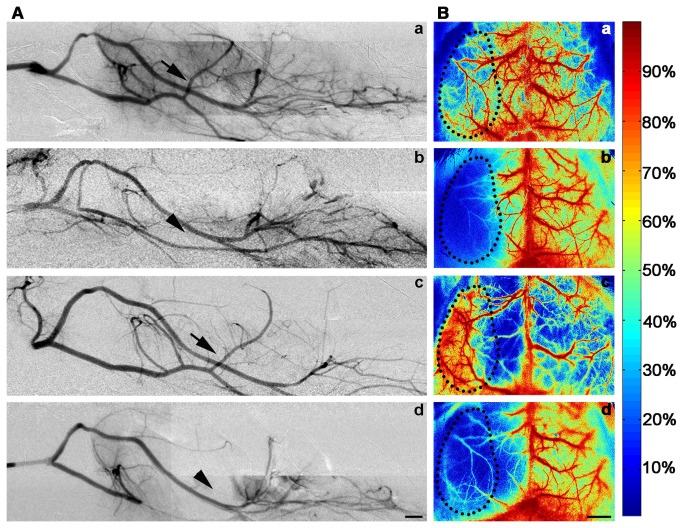
Mouse cerebral vascular morphology imaged by SRA and blood flow measured by LSCI.(A) Cerebral vascular morphology imaged by SRA. (a) cerebral vascular morphology was obtained before middle cerebral artery occlusion (MCAO) in adult mice. CCA, ICA, PPA, PCA, MCA and ACA as well as their branches could be clearly detected. (b) SRA after MCAO showed that CCA, ICA, PPA and PCA could be detected while MCA was missing, suggesting that MCA was occluded. (c) SRA was performed 1 hour after reperfusion in heparin-treated mice, which showed CCA, ICA, PPA, PCA and MCA were well filled with contrast agent Ipamiro. (d) SRA was performed 1 hour after reperfusion in the heparin-free mice, which showed CCA, ICA, PPA and PCA could be detected while MCA was still undetectable. (B) CBF was measured by LSCI. (a) LSCI was recorded in normal mice showing that the CBF of ipsilateral hemisphere was normal, similar to that of the contralateral. (b) LSCI was recorded after MCAO showing that the CBF of the ipsilateral hemisphere decreased to 10% of the baseline. (c) LSCI was recorded 1 hour after reperfusion in heparin-treated mice showing that the CBF recovered to the baseline. (d) LSCI recorded 1 hour after reperfusion in the heparin-free mice showing that the CBF was still low. Arrows indicate that MCA was well filled with blood. Arrowheads indicate the location of MCA, which was undetectable. Broken Circle indicated the MCA territory in the cortex of ipsilateral hemisphere. Bar= 1 mm. Color bar: normalized relative CBF speed (0%~100%). ACA: anterior cerebral artery, CBF: cerebral blood flow, CCA: common carotid artery, ICA: internal carotid artery, LSCI: laser speckle contrast imaging, PCA: posterior cerebral artery, PPA: pterygopalatine artery, SRA: synchrotron radiation microangiography.